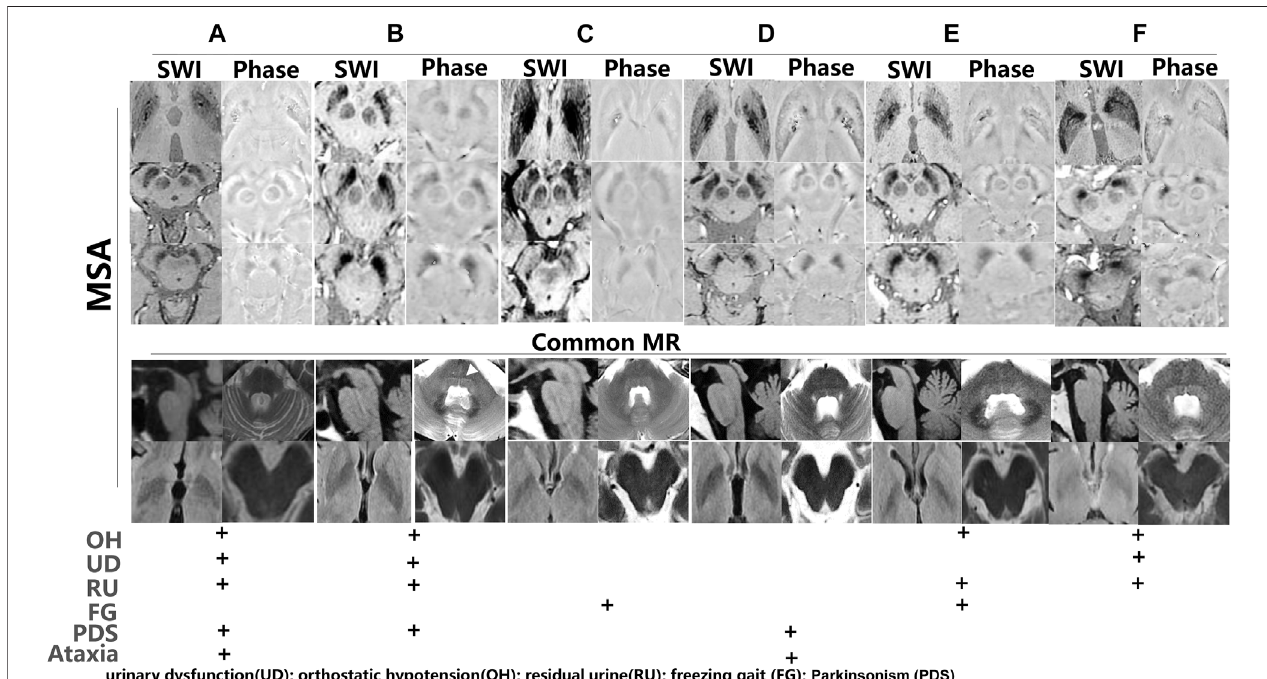
FIGURE 7 | Iron accumulation depicted in multiple system atrophy (MSA). (A – F) Iron accumulation in the substantia nigra and corpus striatum of MSA patients (B, white arrow: hot cross bun sign). Phase imaging of SWI was used to differentiate the presence of calcium from iron. Common brain MR and symptoms such as urinary dysfunction (UD), orthostatic hypotension (OH), residual urine (RU), freezing gait (FG), and parkinsonism (PDS) were used to diagnose MSA.